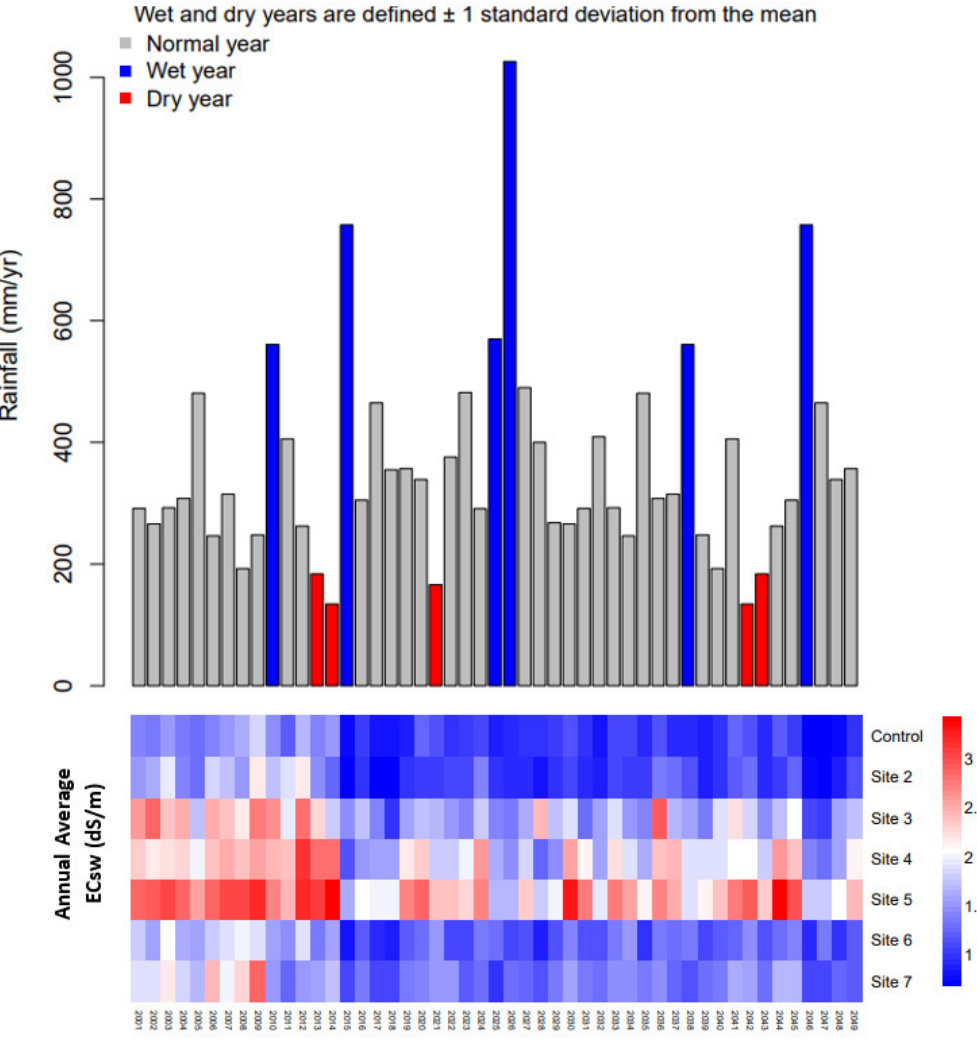
Figure 9. Annual average soil–water salinity for sites irrigated with varying fractions of treated wastewater (2000 to 2049).